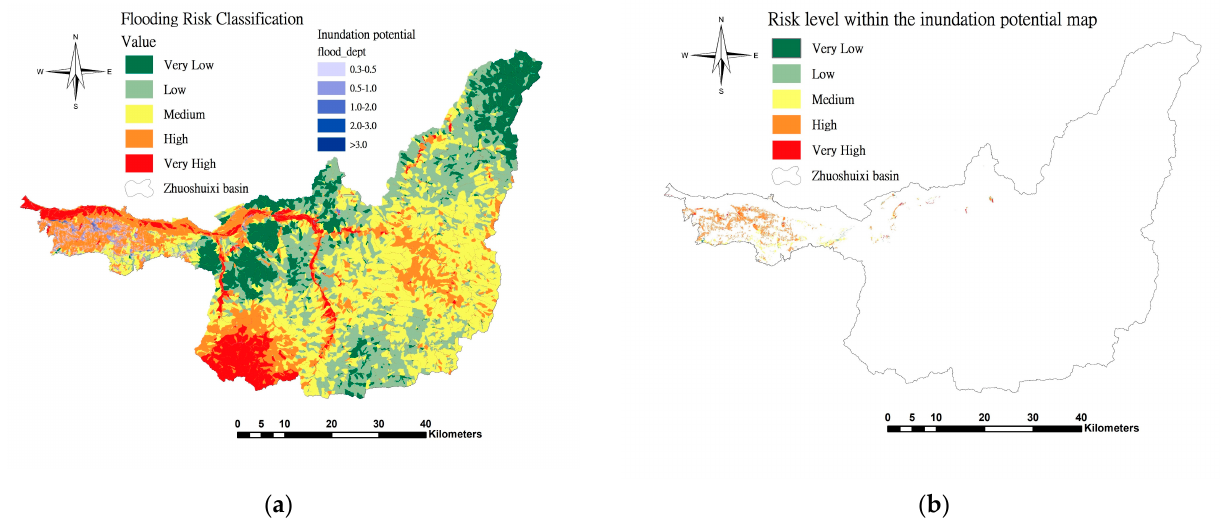
Figure 14. ( a ) The spatial relationship between the flooding potential map and the model results of this study and ( b ) the range of the flood potential map corresponds to the risk level of this study